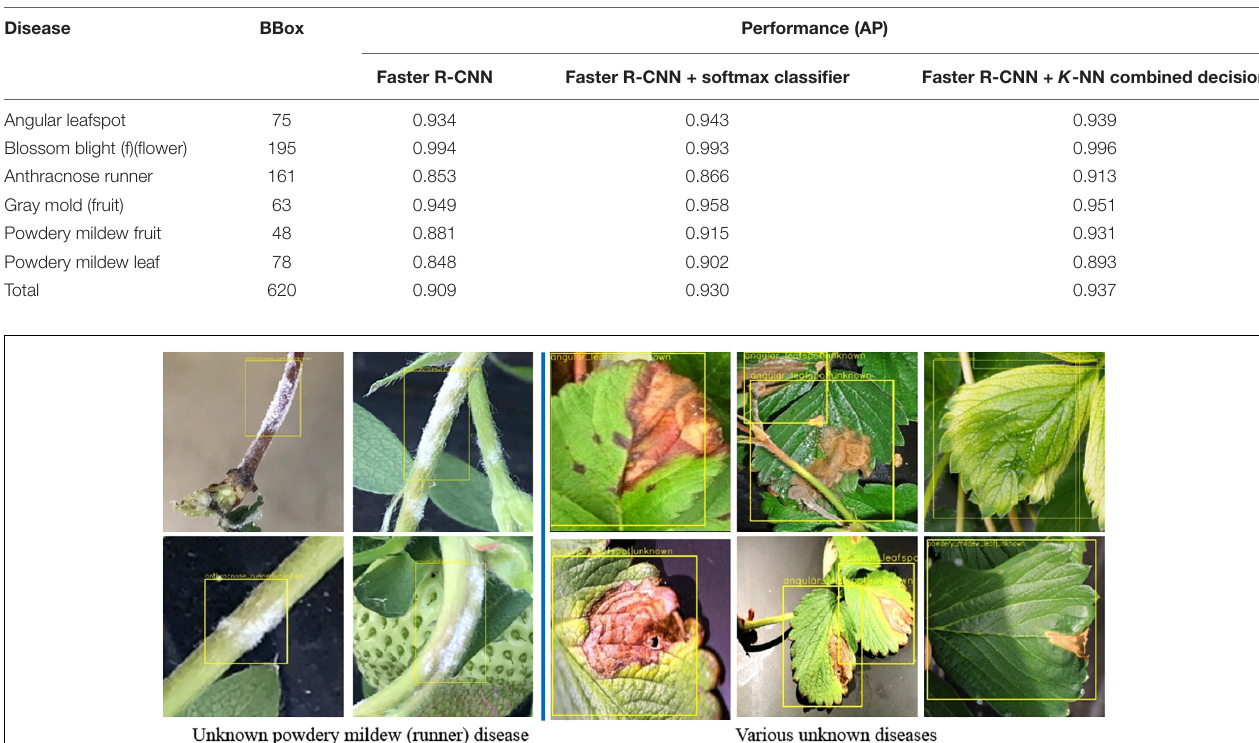
TABLE 6 | Field test results of known disease detection. Disease